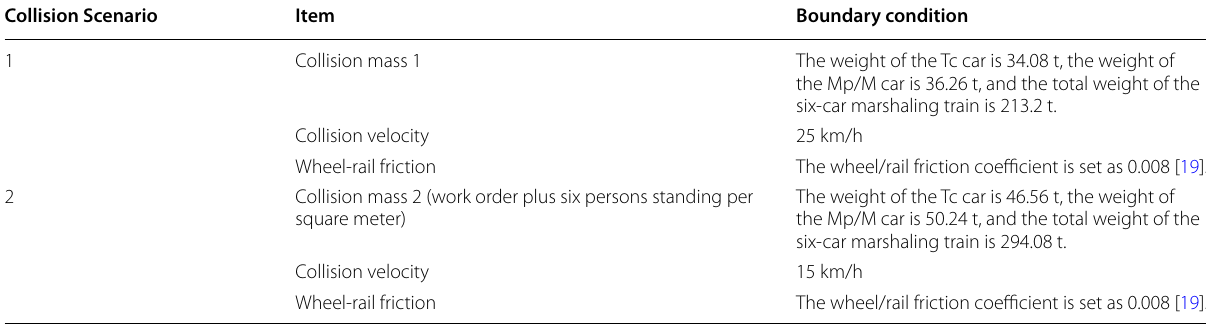
Table 2 Boundary conditions for the collision numerical calculation Collision